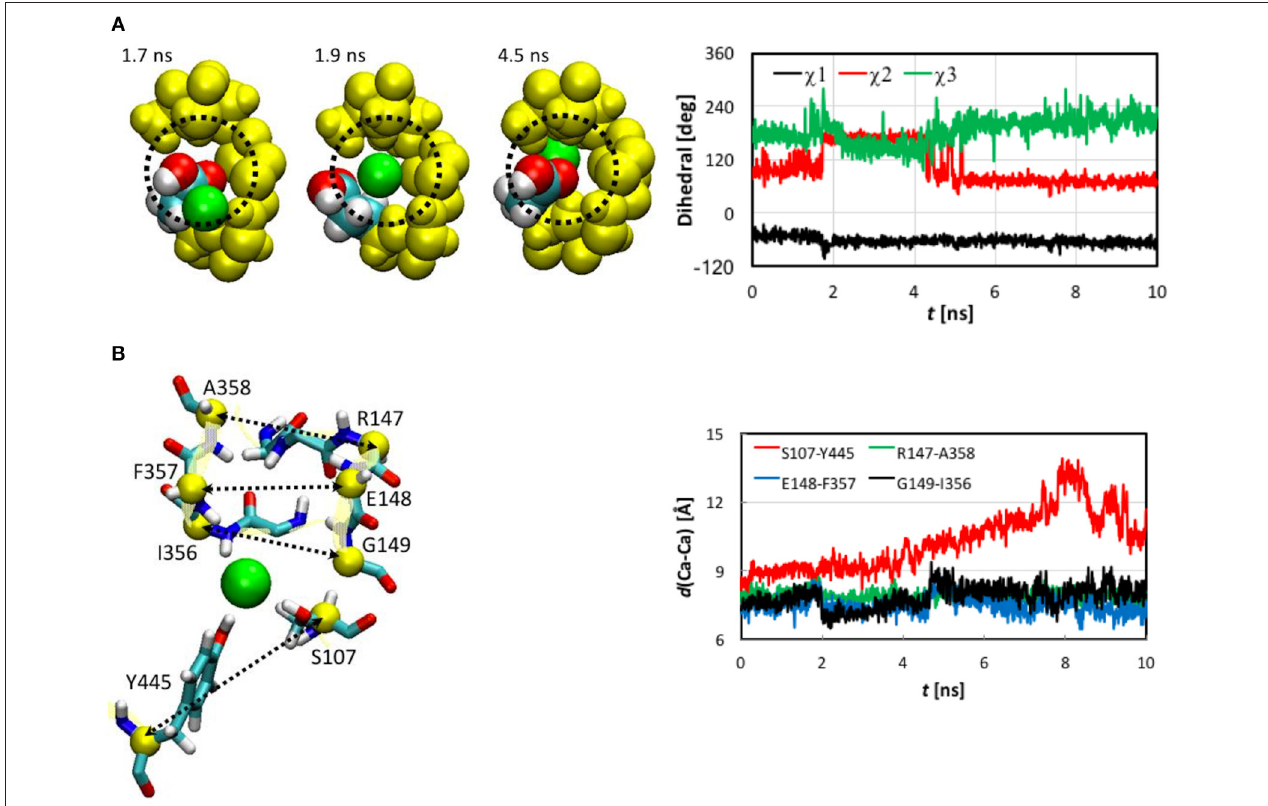
FIGURE 5 | (A) Opening of pore entrance by flipping the Glu148 side chain. Left: Three snapshots (top view) at t = 1.7, 1.9, and 4.5 ns, where the Cl − ion (green), Glu148 side chain (white, H; cyan, C; and red, O), backbones of 146–148 and 355–358 (yellow), and the methylene bridge (-CH 2 -) group of Phe357 (yellow) are displayed as space-filled van der Waals spheres. The dotted circle indicates the pore. Right: Dihedrals χ 1- χ 3 characterizing the conformations of the Glu148 side chain as functions of simulation time. Note that χ 3 was shifted to be in the range of 0 to 360 ◦ instead of the standard − 180 ◦ to + 180 ◦ for better visualization. (B) Distances between pairs of C α atoms (yellow spheres) for selected residues (yellow ribbons). Left: Drawn as sticks are Ser107, Ile356 to Ala35 (backbone only), Arg147 to Gly149 (backbone only), and Tyr445. The Cl − ion is illustrated as a green sphere. Right: Distances as functions of simulation